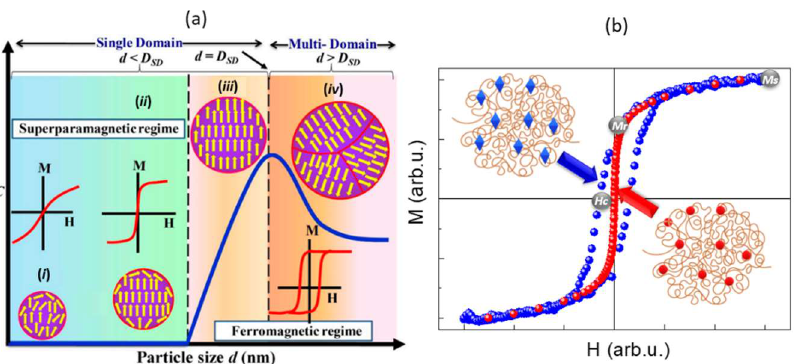
Figure 2. ( a ) A scheme showing the effects of the particle size with variations in H c and M s , from small superparamagnetic nanoparticles to multidomain domain magnetic (nano)particles. (i) Nanoparticles smaller than 3 nm show superparamagnetic behaviour with Hc = 0, and moderate values of M s due to the large contribution of paramagnetic atoms on the particle surface. (ii, iii) As the particle size increases, longer relaxation times are observed, stabilizing the blocked state and increasing the H c . (iv) Lastly, above the critical size for a single-domain formation, the particle is multidomain, which leads to a decrease in H c . ( b ) Hysteresis loops of hard (left) and soft (right) self-healing magnetic composites at the same temperature. The saturation magnetization ( M s ), the remanence magnetization ( M r ) and the coercive field ( H c ) are indicated in grey solid spheres. The figure is reprinted under an open access Creative Commons CC BY 4.0 license